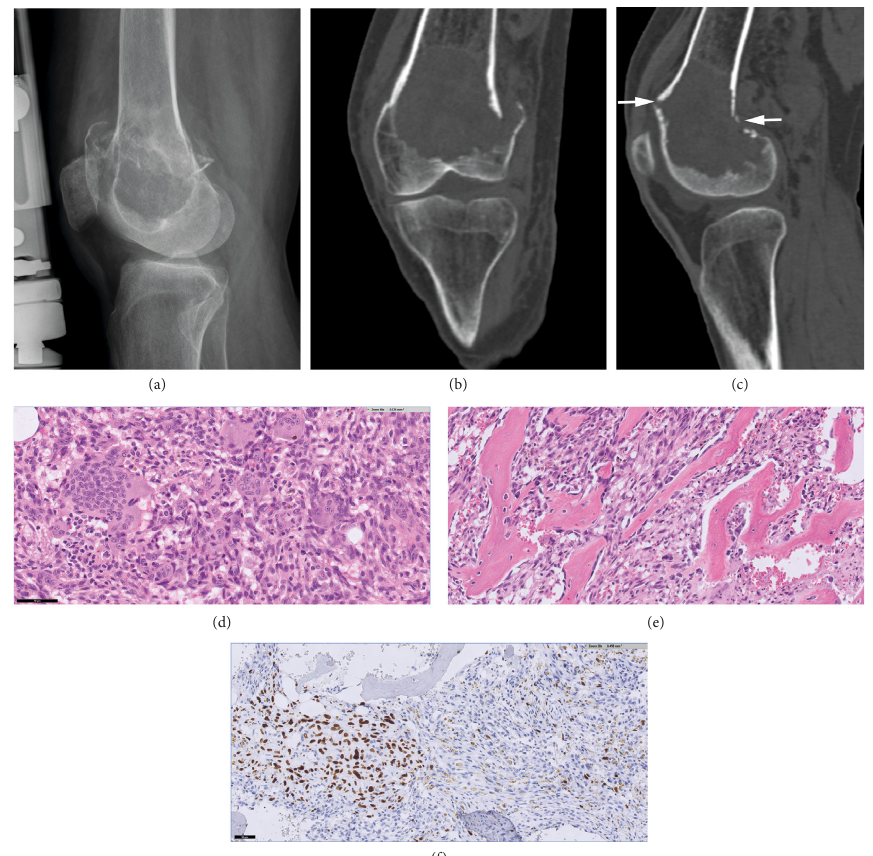
Figure 2: Case 3, a 55-year-old female with a pathological fracture of the femur with underlying GCTB. (a) X-ray at the time of diagnosis showed a pathological fracture through a well-defined osteolytic lesion with a sclerotic margin in the distal femur meta- and epiphysis, initially treated by external fixation. (b) Coronal and (c) sagittal CT images at the time of diagnosis showed the pathological fracture extending through the anterior and posterior cortices (arrows) and no internal matrix. (d) Morphology at the time of curettage shows many mononuclear stromal cells intermixed with large osteoclast-like giant cells without atypical morphological features. (e) At the time of curettage; areas with reactive woven bone with typical osteoblast lining are seen, which may be due to the clinical fracture. (f) At the time of curettage; heterogeneous positive H3G34W staining in stromal